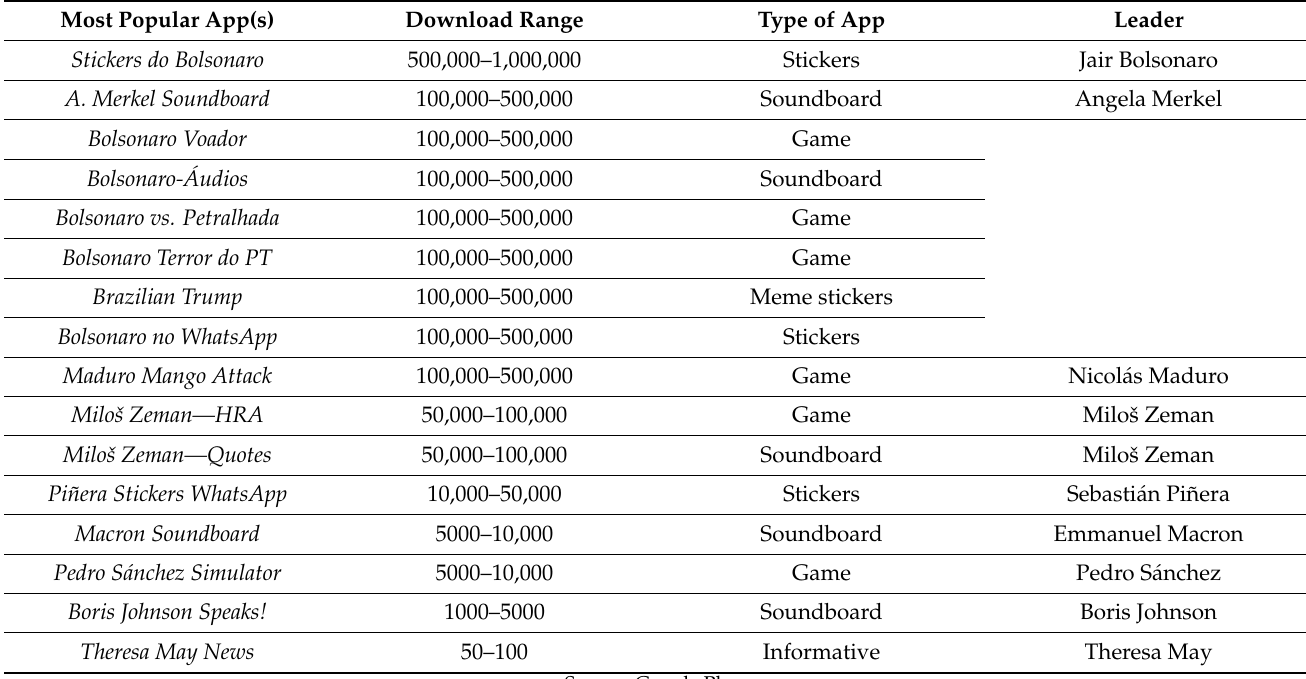
Table 4. Most popular apps on Google